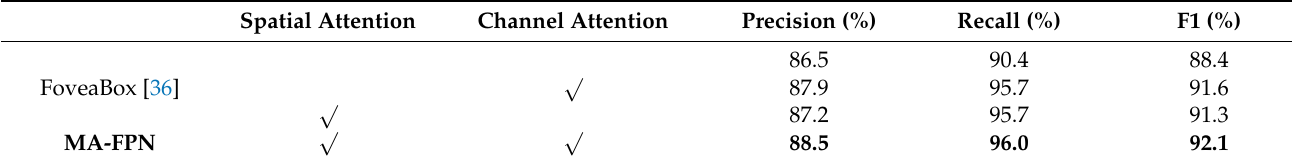
Table 6. Performance of the FPN that incorporates multiple attention mechanisms in VEDAI. Spatial Attention